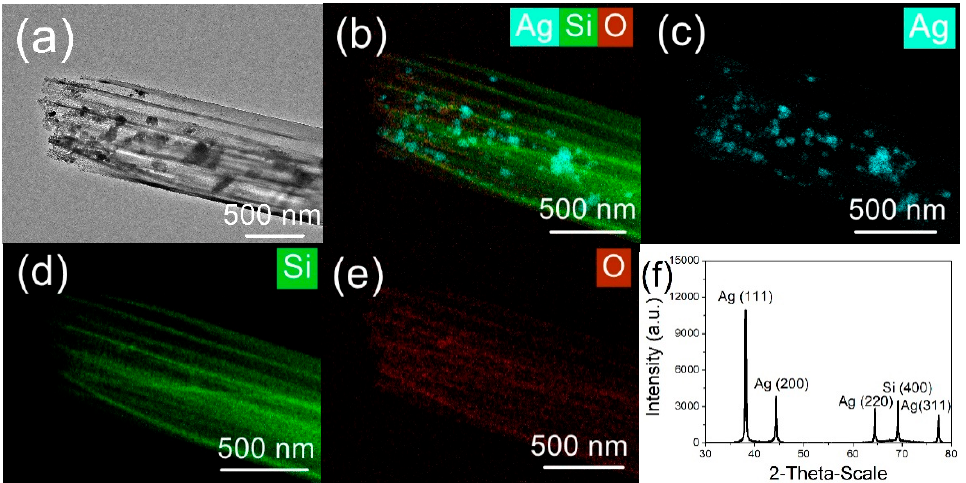
Figure 4. ( a ) TEM image of silicon nanowire array coated with silver nanoparticles. ( b – e ) EDS mapping images of this array: ( b ) combined Ag, Si, and O map; ( c ) Ag map; ( d ) Si map; ( e ) O map. (f) XRD pattern obtained from this array. The Ag + concentration used was 1.25 mM and the UV irradiation time was 10 min.